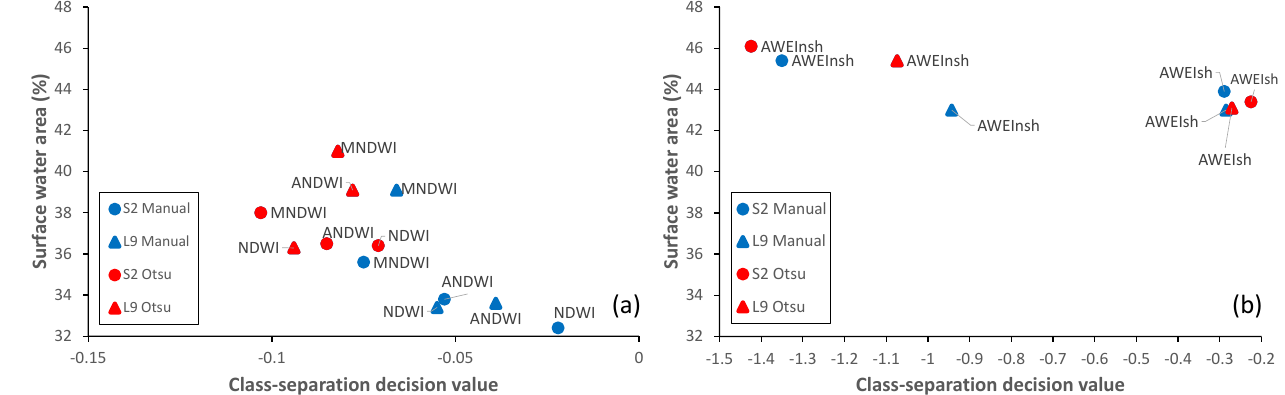
Figure 8. Relationship between the percentage area estimated for the water surface in the selected segment of the Lower Tagus River (Portugal) and the water/non-water class segmentation decision values (estimated manually and by the Otsu method) used to classify the spectral water indices: ( a ) NDWI, MNDWI, and ANDWI; and ( b ) AWEIsh and AWEInsh. Data are from Sentinel-2 (S2) and Landsat 9 (L9). The remote sensing data spatial resolution is 20 m for S2 (8 July 2022) and 30 m for L9 (7 July 2022), for similar discharge